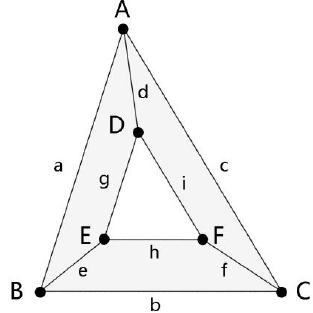
Figure 7. Structure of the epidermal unit of the triangle (self-developed).